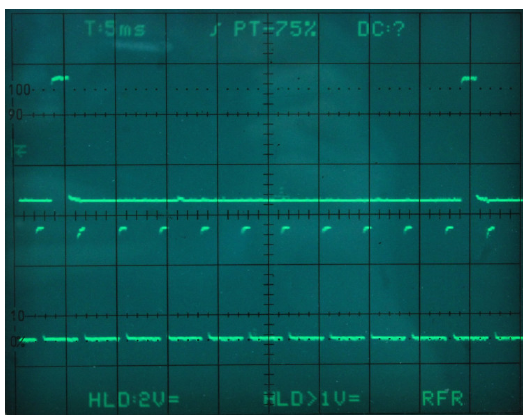
Figure 8. Timing of a series of 10 data acquisition operations (lower trace high periods) and the delivery of the packet through the WebSocket (upper trace high periods). The lower trace is the same as Figure 7, the other is high during network operation of the